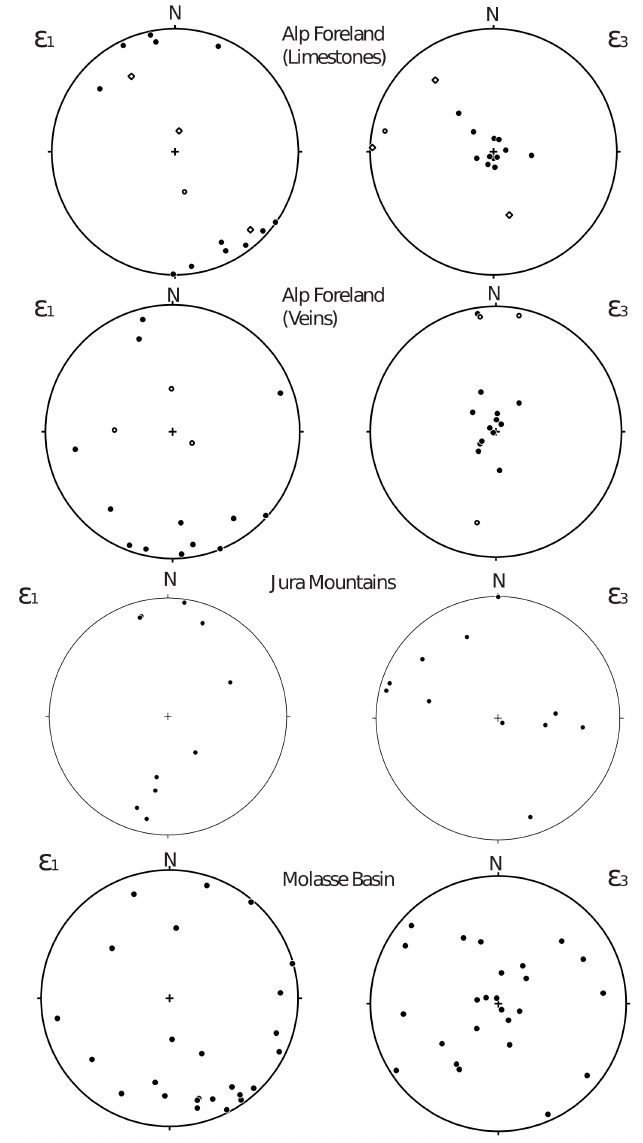
Figure 7. Lower hemisphere stereoplots of calcite strain data for the frontal Alps and foreland (e shortening axes; e3 = extension axes). Key: filled circles = LPS data; open circles = LNS fabric; open EV strain overprints. Strain data are in Tables 1 and 2 and field locations in Appendix